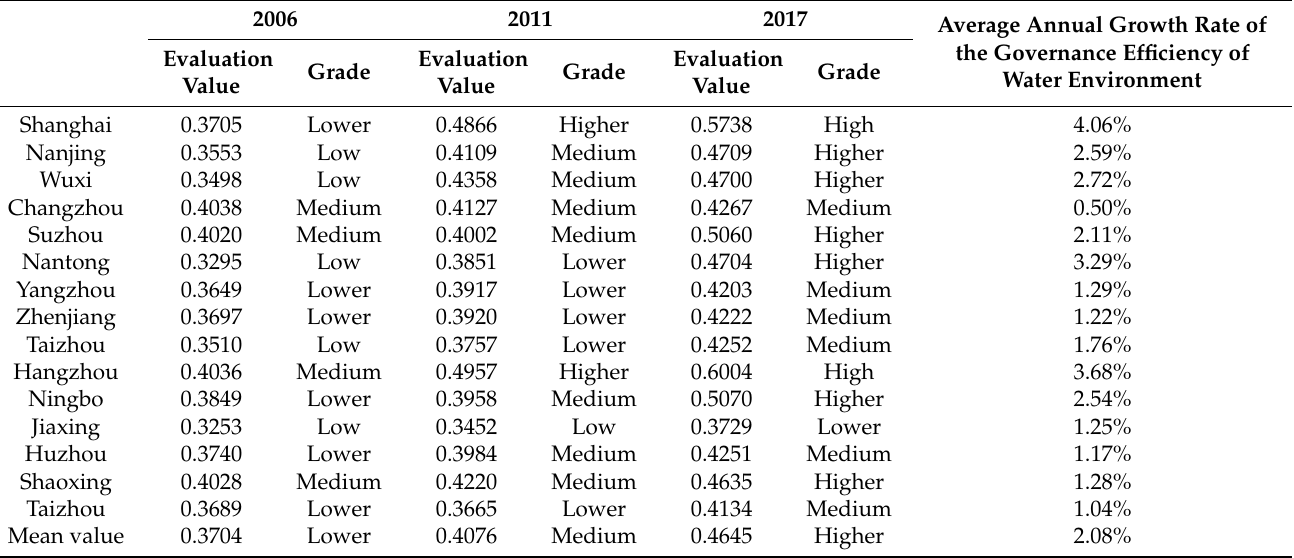
Table 3. Governance efficiency index and evolution for water environment of Yangtze River